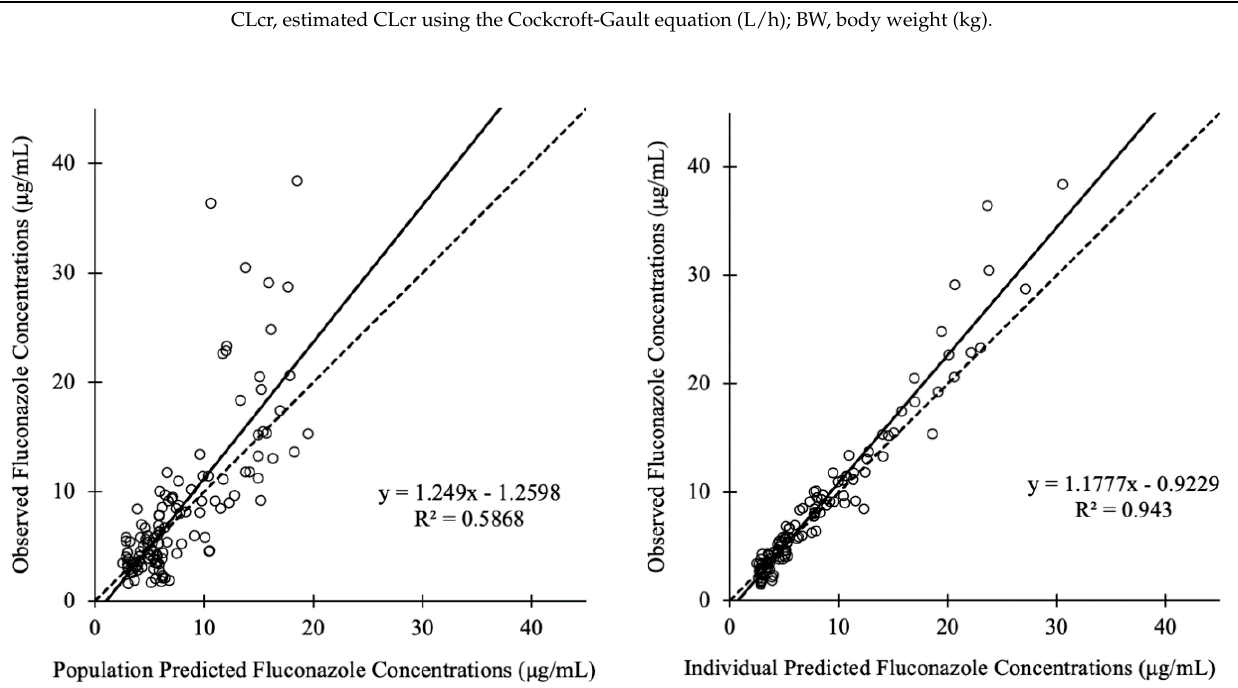
Table 2. Parameter estimates of fluconazole for the final covariate one-compartment model with first order input for oral administration.